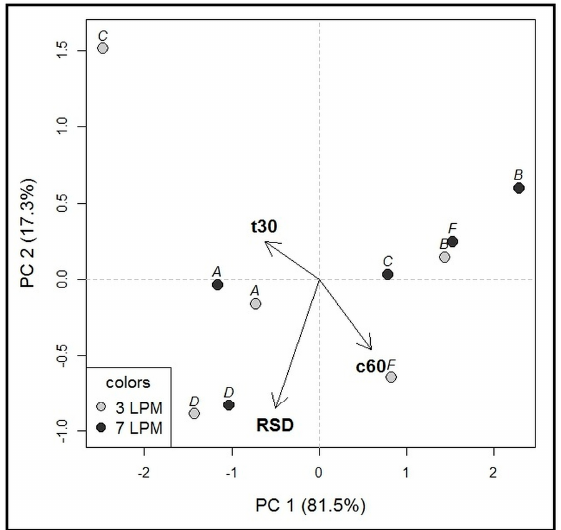
Figure 6. PCA biplot for Phase 2 (100 mL volume). Objects included in the model: five dissolution compartment types (A, B, C, D, F), two agitation rates—7 and 3 LPM. Variables included in the model: t30, c60, median RSD. Higher agitation rate was associated with lower median RSD values (different positioning of 3 LPM and 7 LPM measurements). Highest robustness was obtained for the compartment types B and